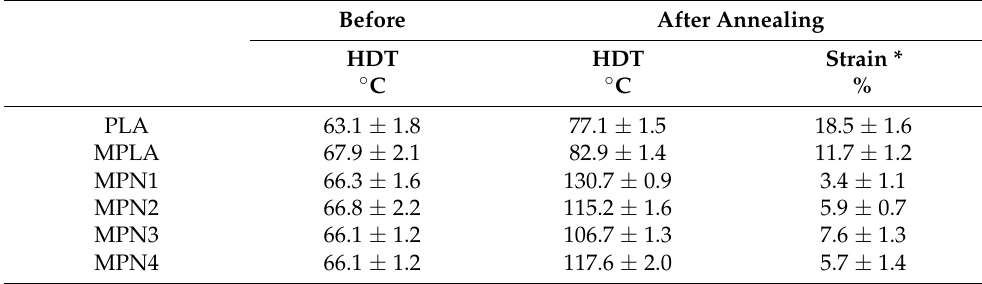
Figure 3. Deflection under load as a function of temperature plots of MPLA and its biocomposites before (dash lines) and after (solid lines) annealing. Table 4. HDT parameters calculated for MPLA and its biocomposites.